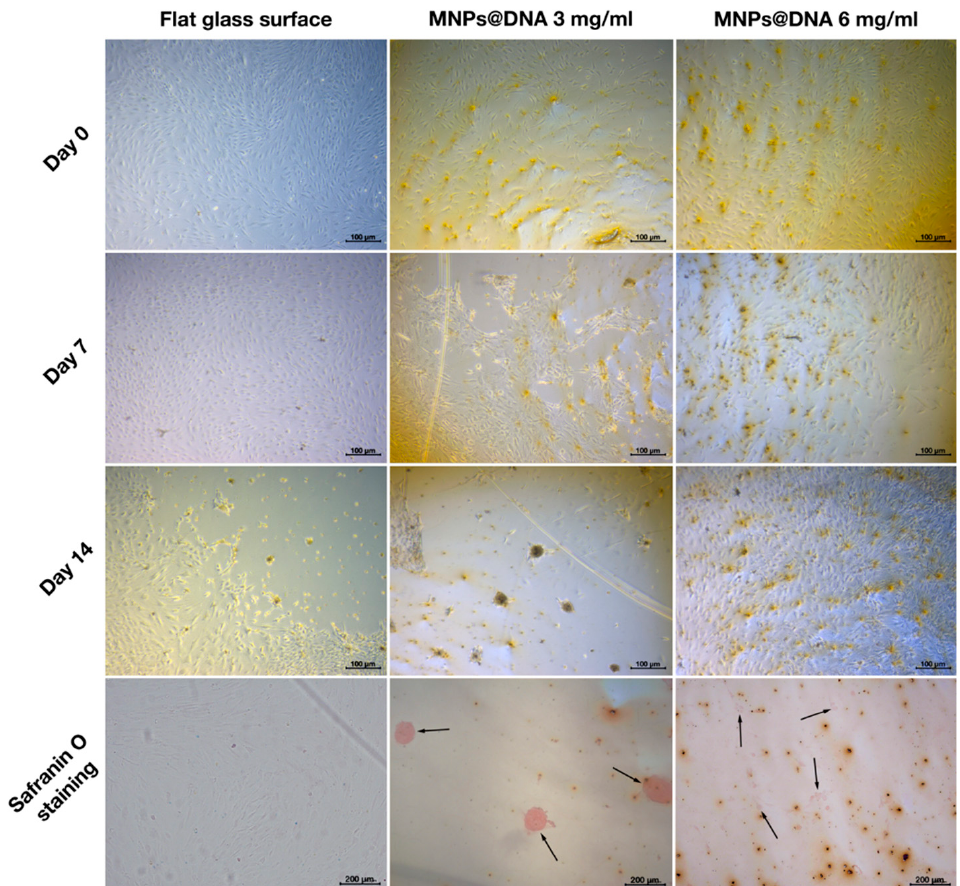
Figure 7. Chondrogenic differentiation of hMSCs on surfaces coated with a solution of 3 and 6 mg/mL of magnetic nanoparticles with DNA (50 µg/mL). The chondrocytes were stained with safranin O. The arrows show the aggregates of chondrocytes.